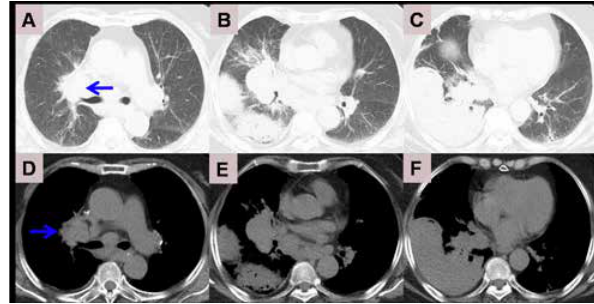
Figure 2: Computed tomography guided transthoracic core needle. Puncture needle is in the consolidation area of right lower lobe.